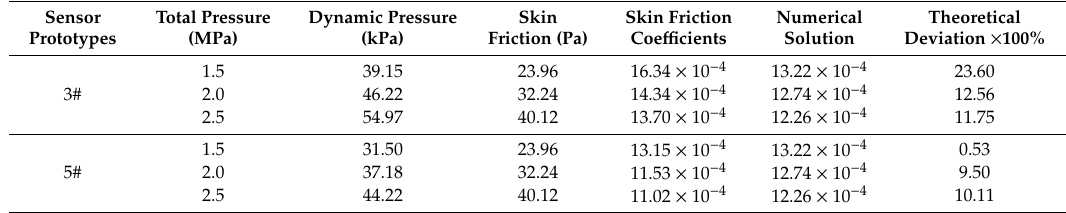
Figure 15. Dynamic calibration curves under turbulent flow conditions. Table 8. The data analysis of dynamic calibration under turbulent flow conditions.